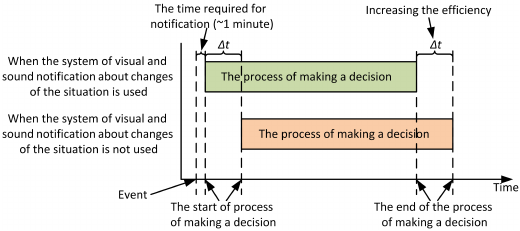
Figure 2. Schematic representation of the principle of increasing the efficiency of solving tasks of planning department by using the notification system about changes of